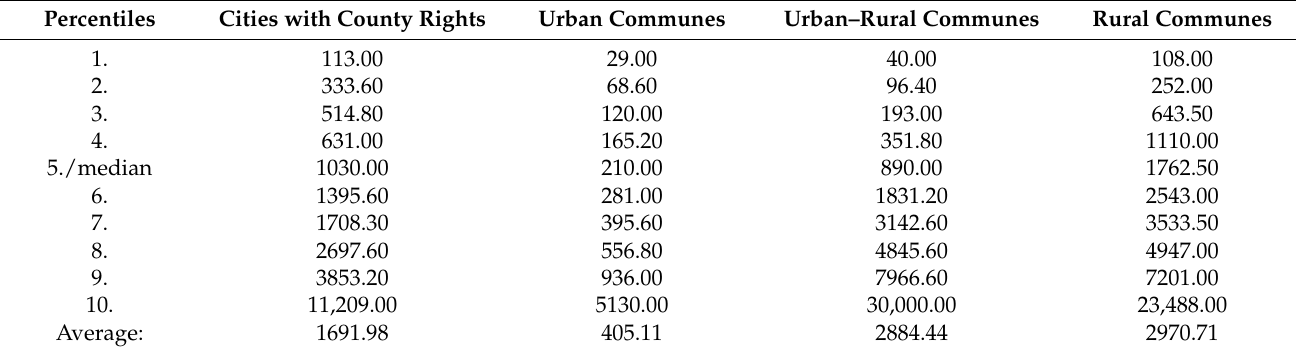
Table 6. Percentiles and the average size of the degraded area in the respective types of the communes (ha).